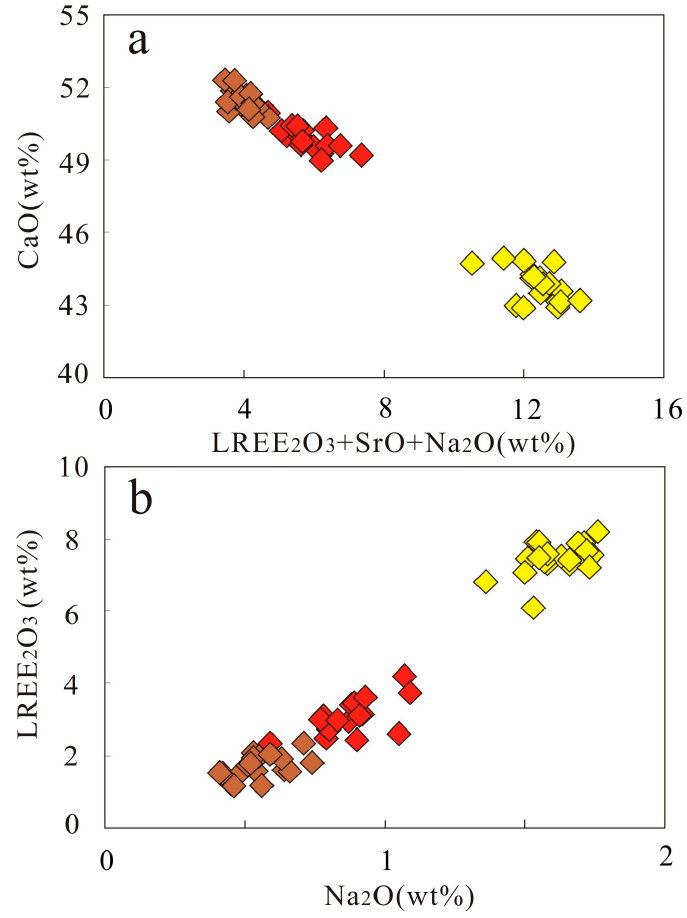
Figure 8. Plots of ( a ) CaO vs. (LREE 2 O 3 + SrO + Na 2 O) and ( b ) Na 2 O vs. LREE 2 O 3 for the three types of apatite.